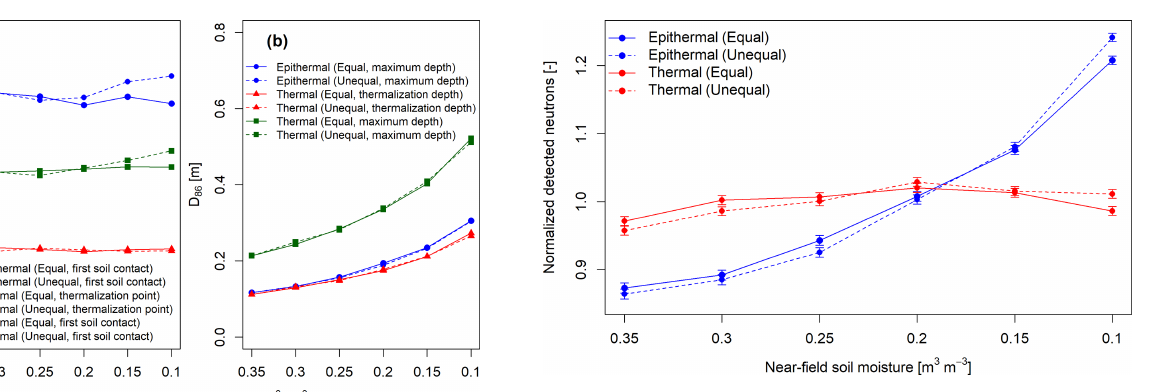
Figure 7. The simulated normalized thermal and epithermal neu- tron response when soil moisture in areas covered with mineral and peatland soils decreases at equal intervals (solid lines) and when peatland soil moisture decreases twice as much (dashed